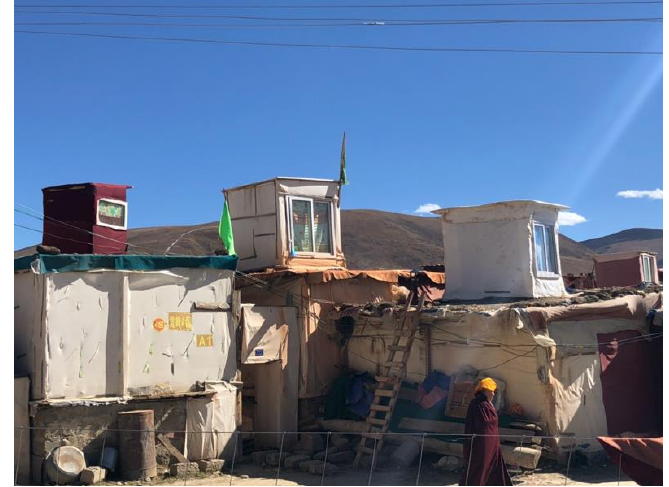
Figure 5. Makeshift houses at Yachen Gar with meditation huts on top of them.